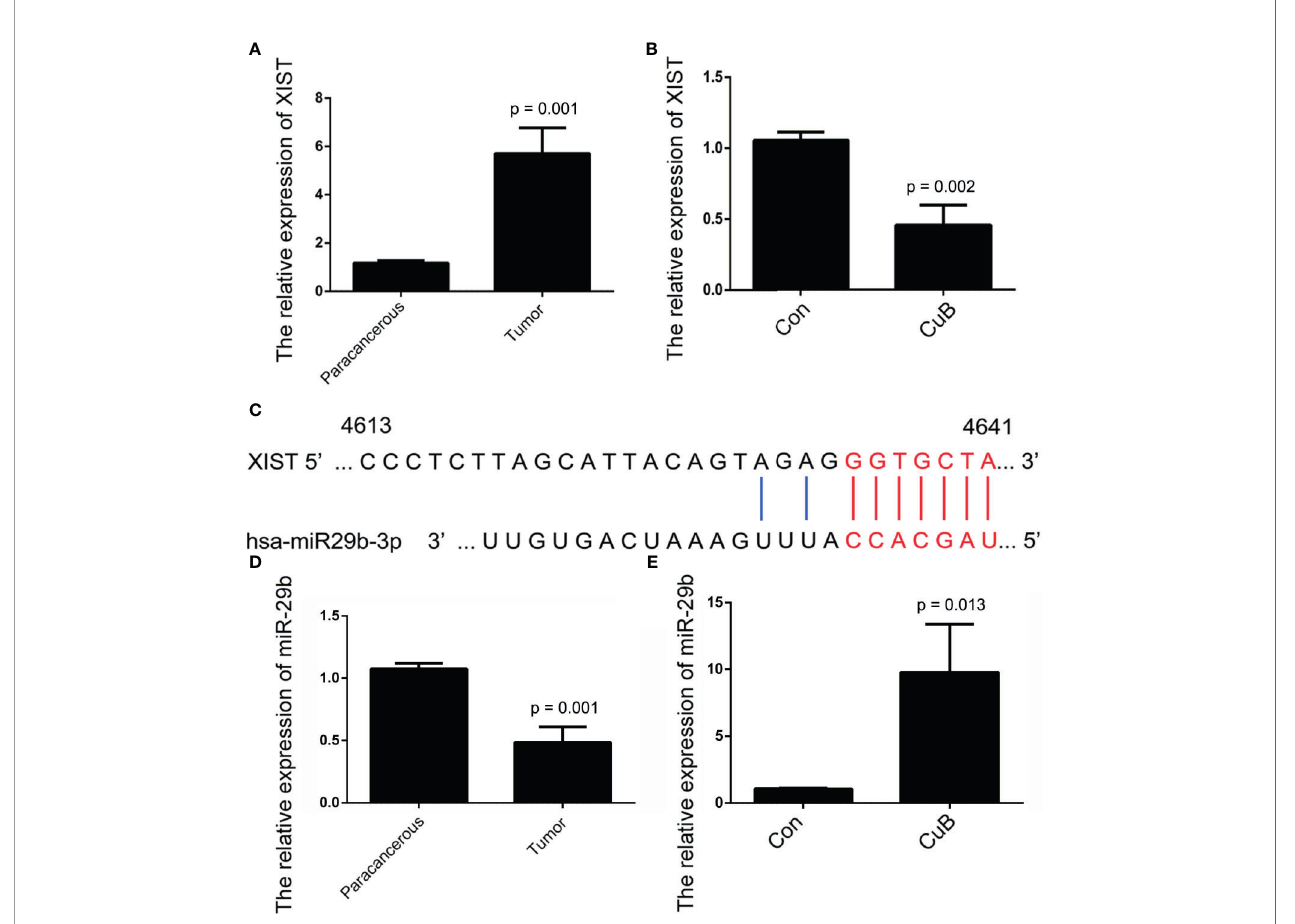
FIGURE 3 | Analysis of XIST and miR-29b expression after CuB treatment. (A) Relative expression of XIST in TSCC patients (N = 3) using qPCR. (B) The relative expression of XIST , analyzed by qPCR, after CuB treatment of SCC9 cells. (C) Schematic representations of the sequences of XIST and miR-29b. (D) Relative expression of miR-29b among TSCC patients (N = 3). (E) Relative expression of miR-29b, analyzed by qPCR, after CuB treatment of SCC9 cells. Data are expressed as mean ± SD (n = 3). Statistical signi fi cances between groups were evaluated using t-test for independent